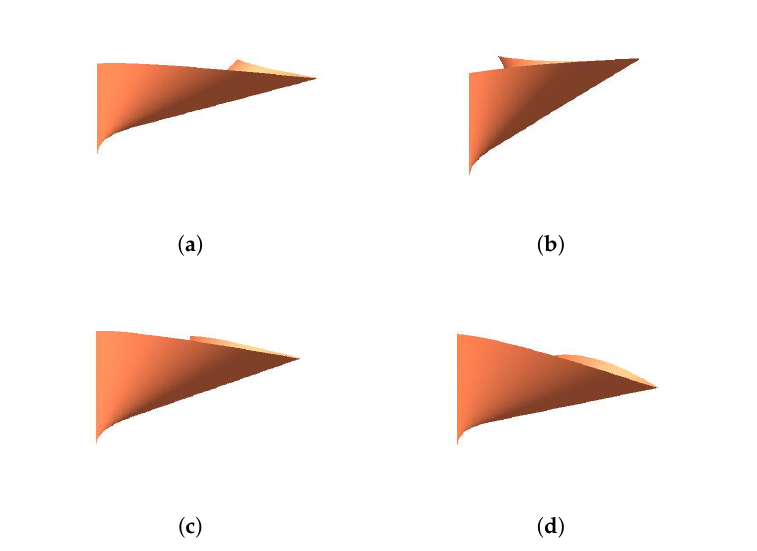
Figure 9. The effects of parameter α 3 on the tangent developable surface. ( a ) α 1 = π ( b ) α 1 = π